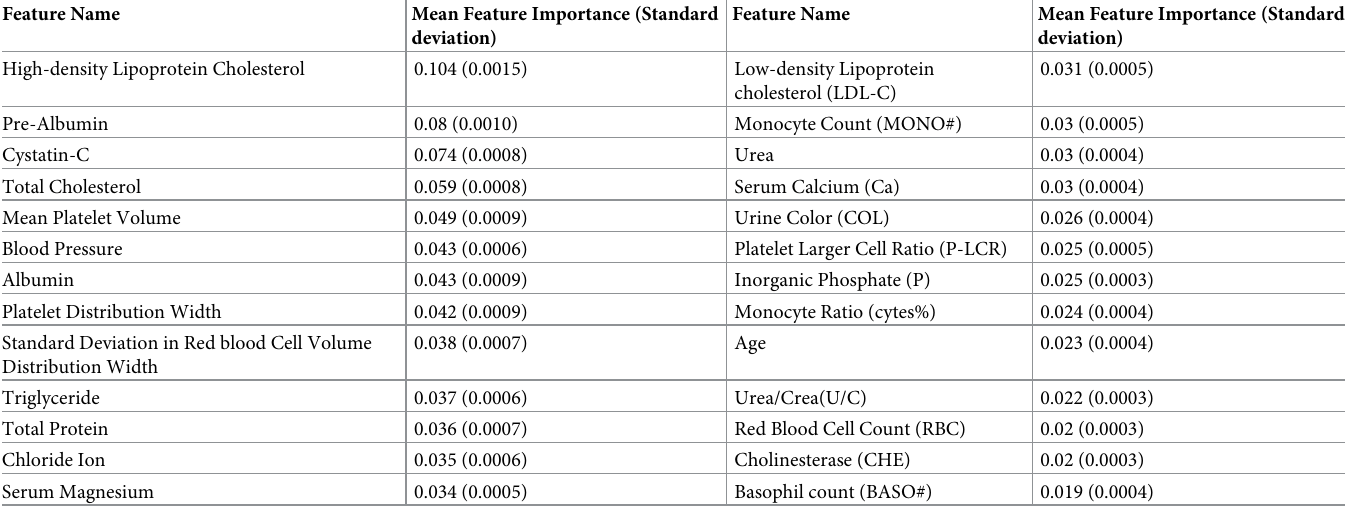
Table 2. Feature importance of 26 selected features using Boruta with random forests. Feature